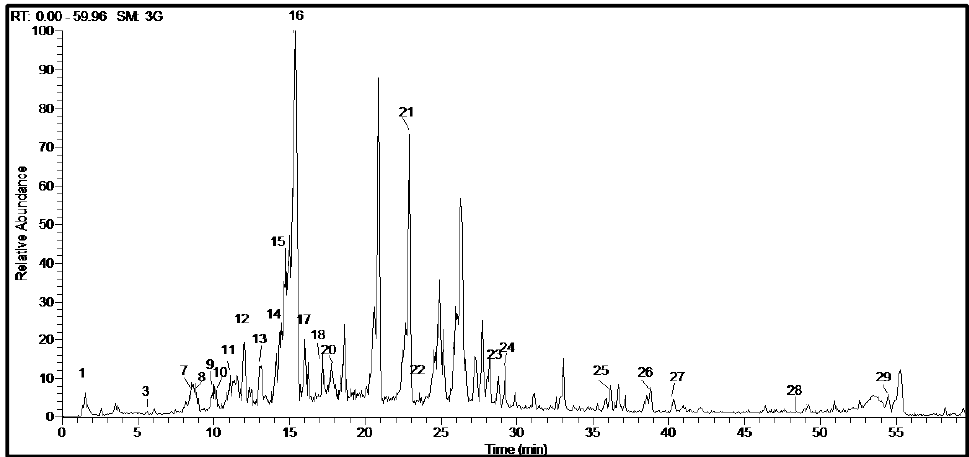
Figure 2. HPLC-ESI-MS base peak chromatogram of C. aethiopica leaf total methanol extract in the negative ion mode. Table 2. Metabolite profiling of C. aethiopica leaf total methanol extract via HPLC-PDA-ESI-MS/MS in the positive and negative ion mode.